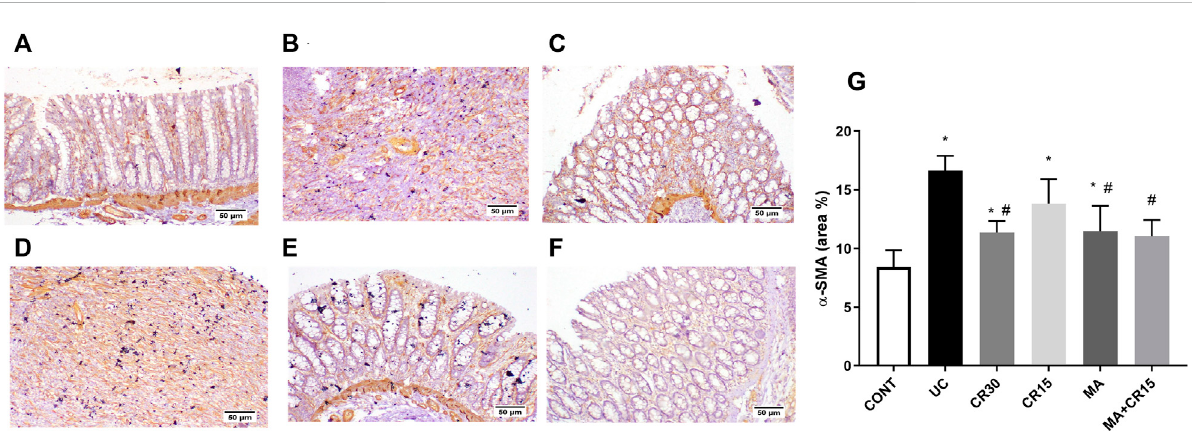
FIGURE 9 Effect of mirabegron and/or carvedilol on the colonic α -SMA immunoreactivity in rats with IAA-induced ulcerative colitis. Section of (A) CONT group shows a normal expression of α -SMA in the lamina epithelia, lamina propria, and muscularis mucosa, while that of (B) UC group and (D) CR15treatedgroupshowhigherexpressionof α -SMAintheinjuredintestinalmucosa.Treatmentwith (C) CR30, (E) MA,and (F) MA+CR15revealsfew expressions of α -SMA in the mucosa. (G) shows the % area of α -SMA staining (6 fi elds in each section). Data are presented as mean ± SD (n = 3rats/group).Statisticalanalysiswascarriedoutusingone-wayANOVAfollowedbyTukey ’ s posthoc test; p < 0.05,ascomparedtothe(*)CONTand (#) UC groups. CONT, control; CR, carvedilol; IAA, iodoacetamide; MA, mirabegron; α -SMA, alpha-smooth muscle actin; UC, ulcerative colitis.